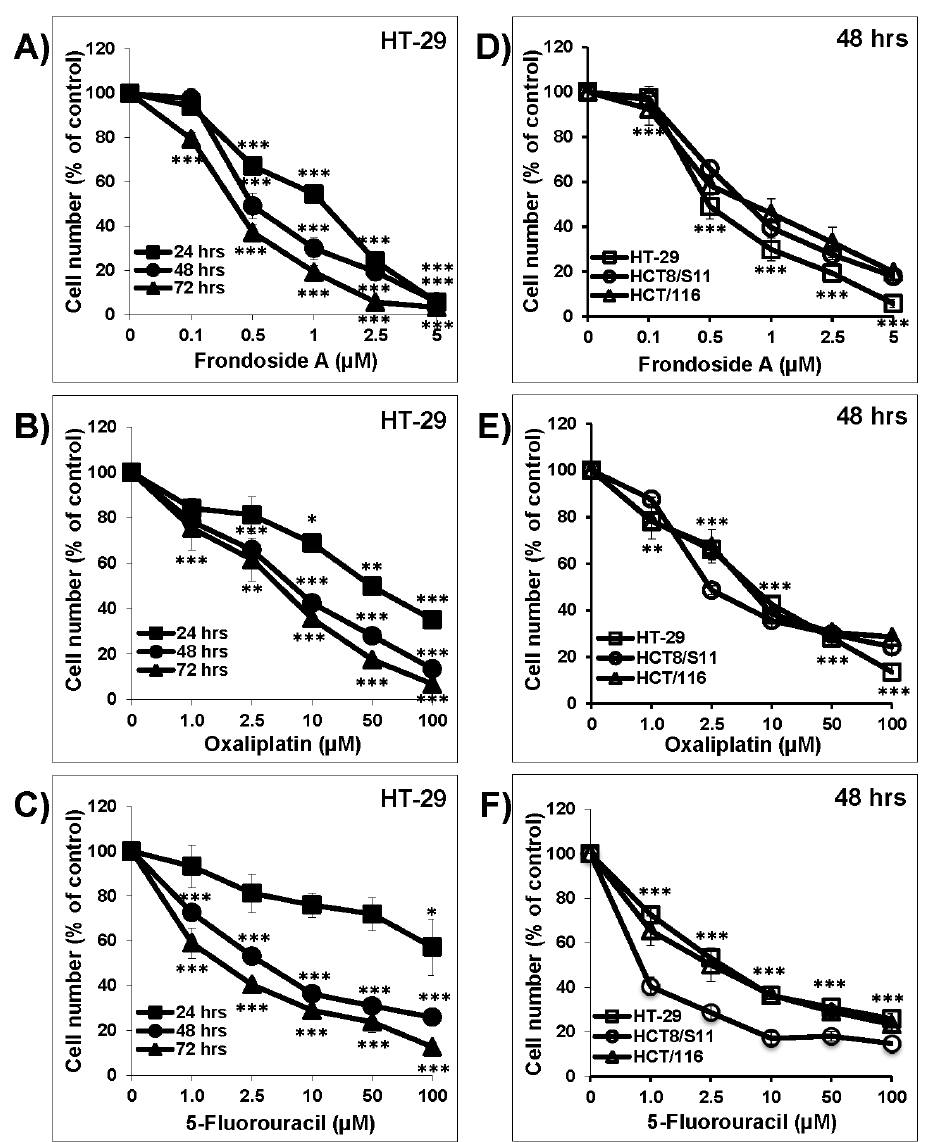
Figure 1. Frondoside A inhibition of colon cancer cell numbers compared to oxaliplatin and 5-fluorouracil. Exponentially growing HT-29 cells were treated with vehicle (0.1% DMSO) and the indicated concentrations of Frondoside A ( A ), oxaliplatin ( B ), and 5-fluorouracil ( C ) for 24 to 72 h. The effects of the three drugs were confirmed at 48 h in two additional colon cancer cell lines, namely, HCT8/S11 and HCT-116 ( D – F ). Cell count was determined as described in Materials and Methods. All experiments were repeated at least three times. Shapes represent means; bars represent S.E.M. * Significantly different at p < 0.05. ** Significantly different at p < 0.01. *** Significantly different at p <